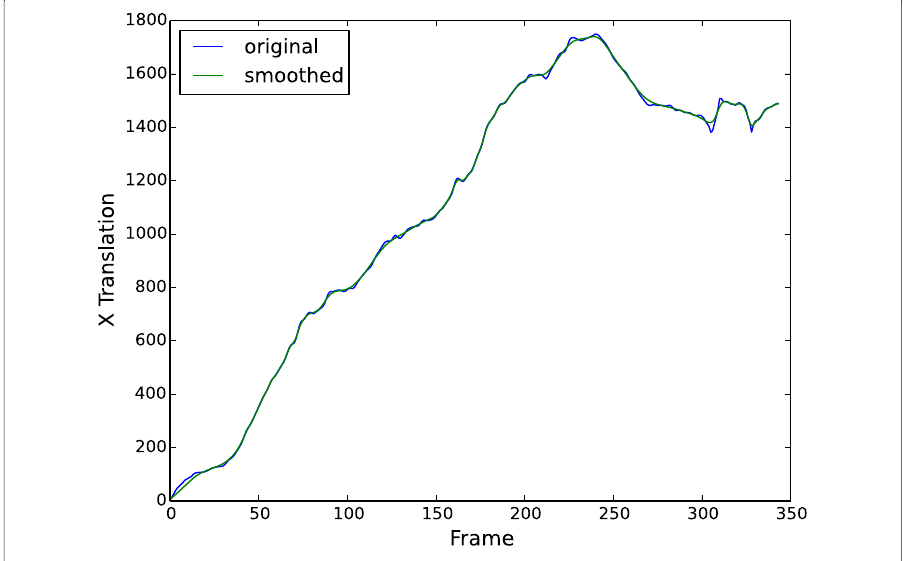
Fig. 1 Horizontal translation path of a